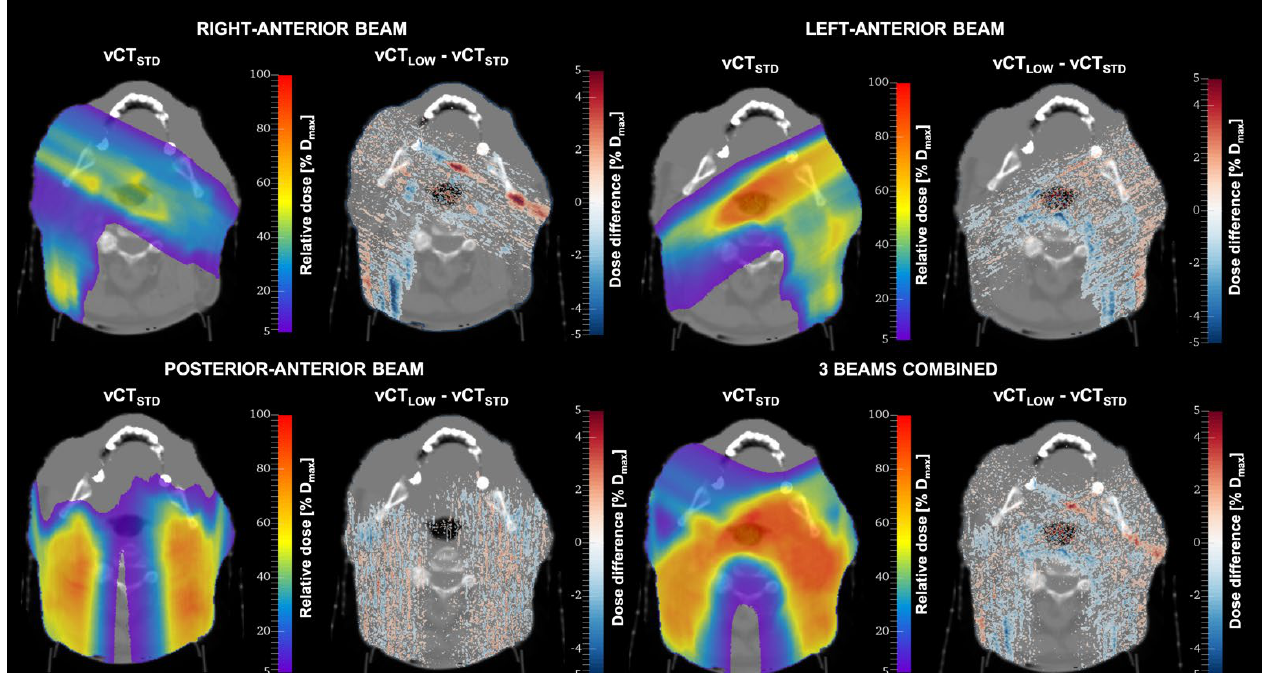
Figure 10. Dose distributions calculated for one patient in standard-protocol CT images (vCT STD ) and the difference between the dose distributions calculated in vCT STD and low-dose CT (vCT LOW ). Table 3. Mean and min–max 2%/2 mm gamma pass rates calculated in the low-dose CT volumes ( CTDI vol = 4.2 mGy) using the standard-protocol CT volume as reference.